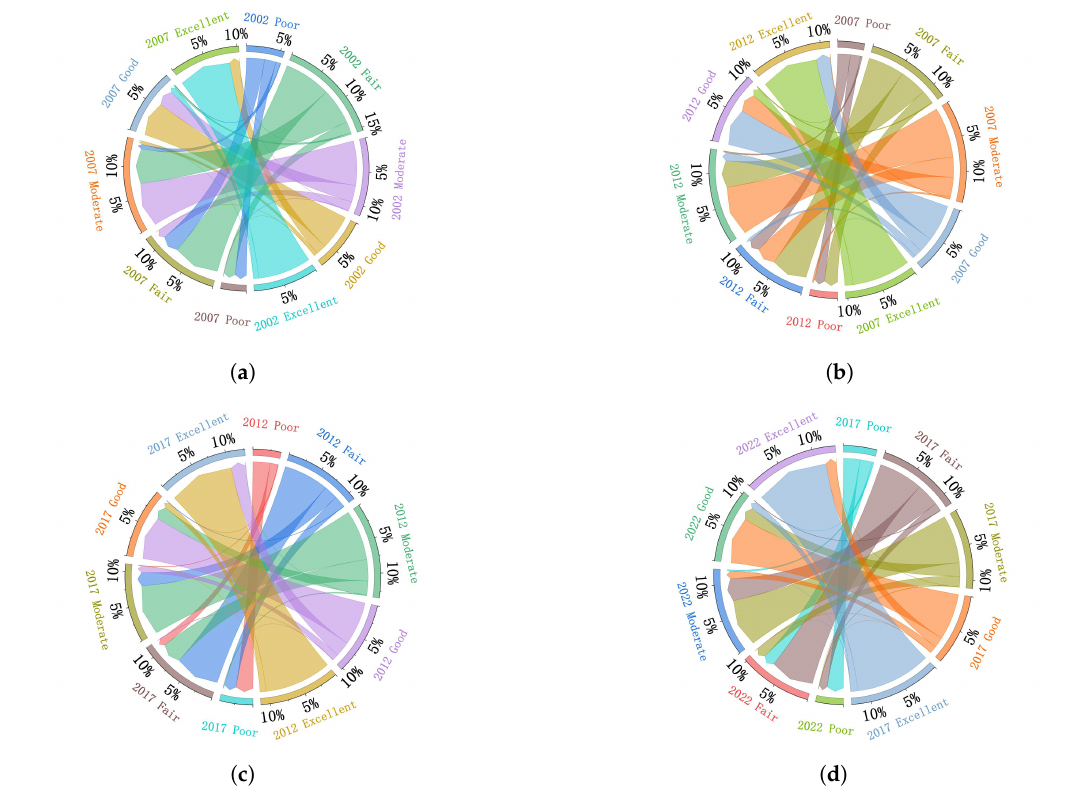
Figure 15. Chordal graph of RSEI transfer matrix of ( a ) 2002–2007, ( b ) 2007–2012, ( c ) 2012–2017, and ( d )